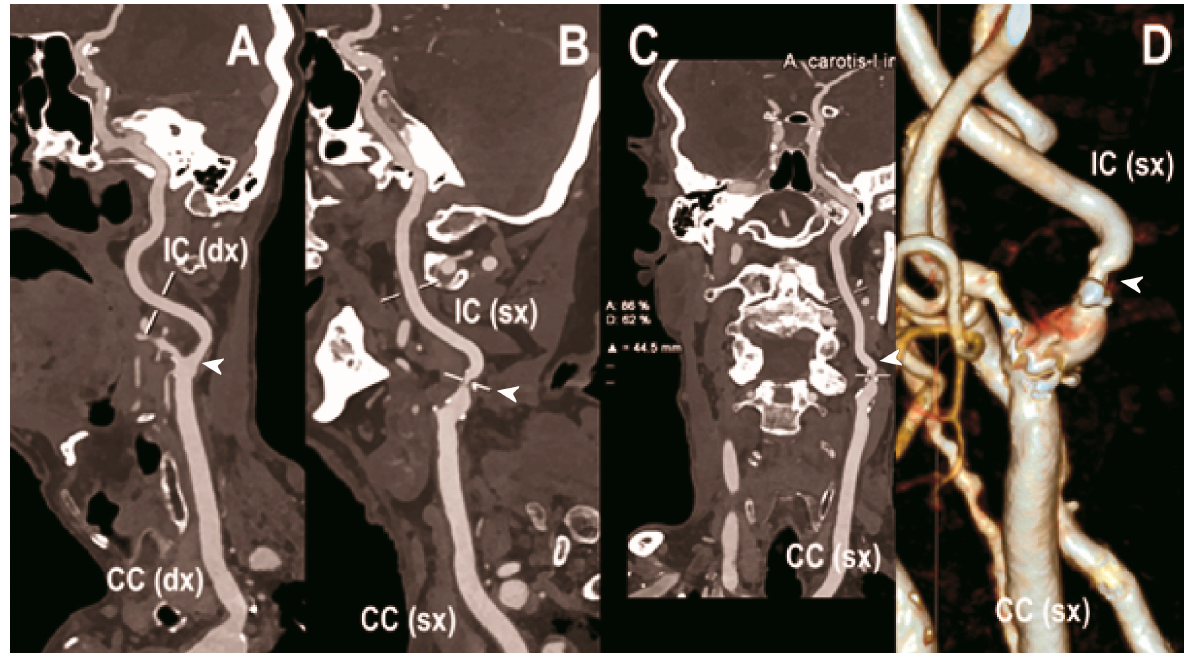
Figure 3. Carotid CT angiography using photon-counting computed tomography. The figure shows advanced reconstructions of a carotid artery tree derived from a photon-counting CT (Scanner: NAEOTOM Alpha, Siemens) acquisition ( A – D ). In ( A ), a longitudinal multiplanar reconstruction shows the right common and internal carotid artery with no significant luminal stenosis and a predominantly calcified atherosclerotic plaque at the carotid bifurcation (arrowhead). In ( B ), a longitudinal multiplanar reconstruction shows the left common and internal carotid artery with a significant luminal stenosis in the post-bulbar region of the internal carotid artery (arrowhead). In ( C ) the quantitative assessment of the stenosis (arrowhead) and in ( D ) the 3-dimensional volume rendering of the lesion